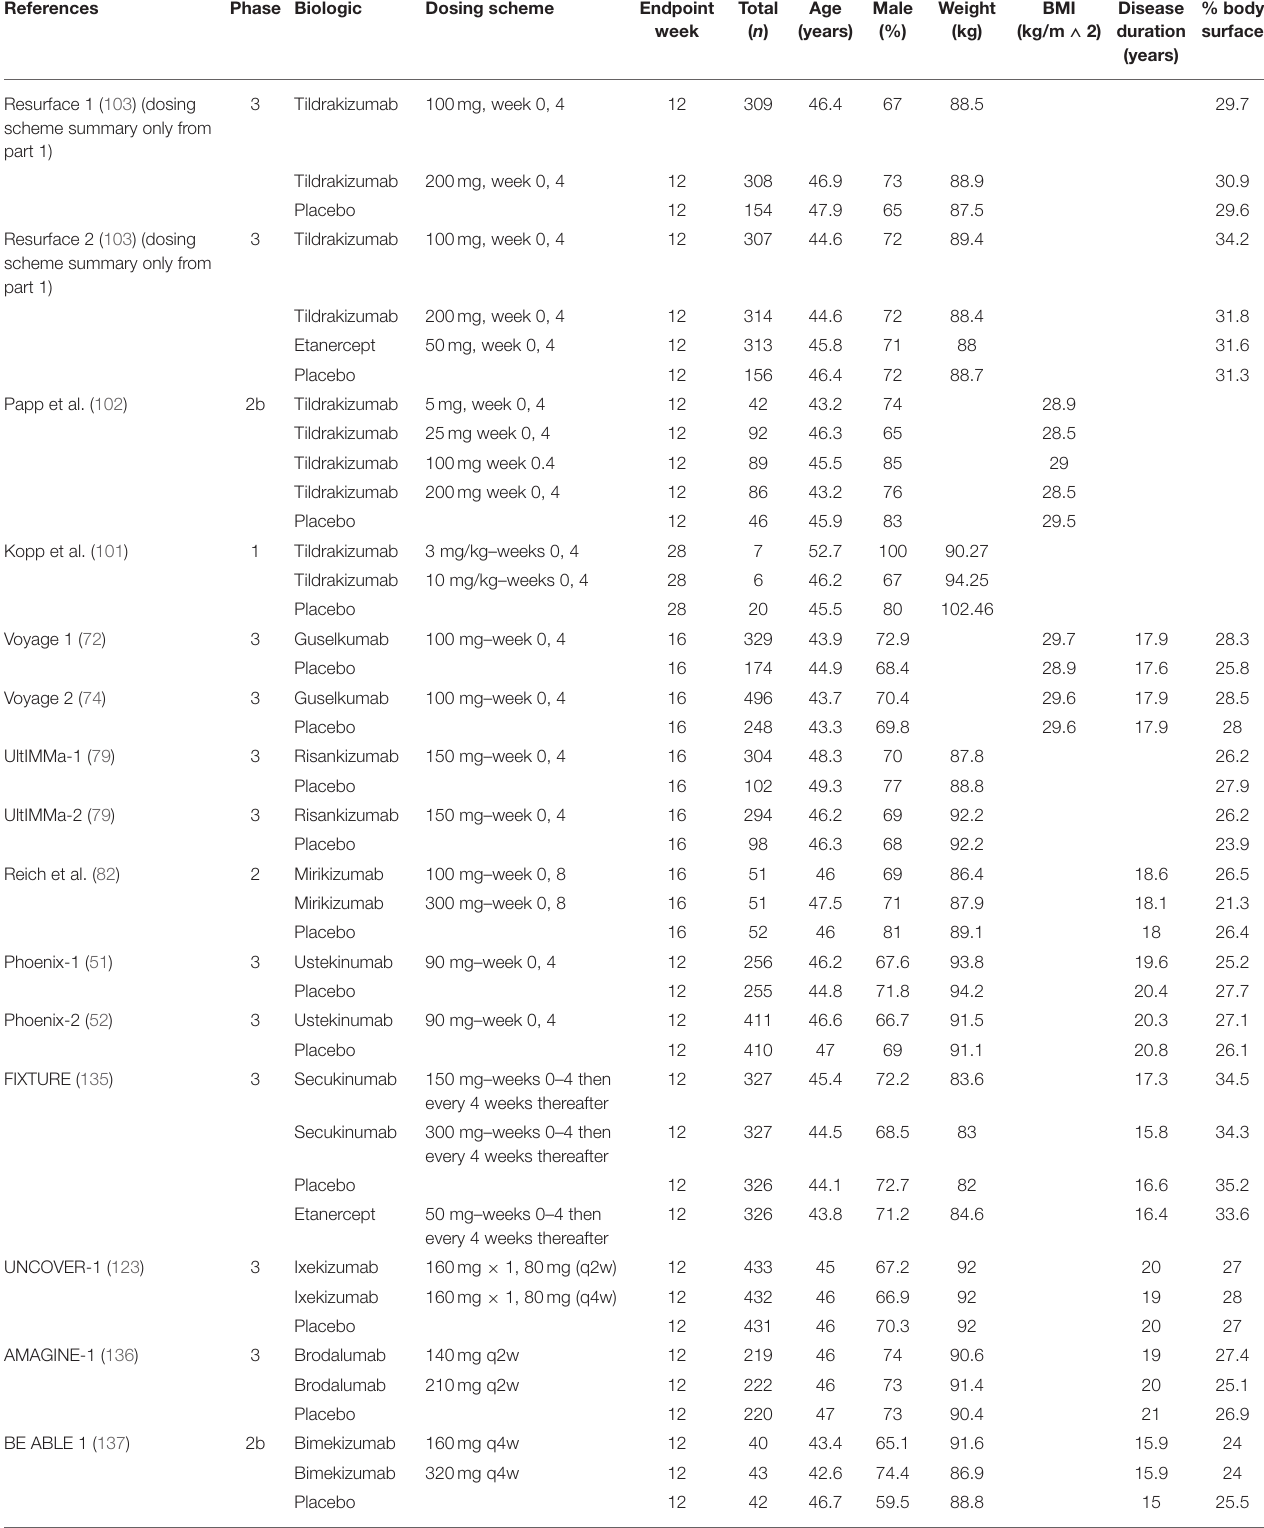
TABLE 2 | Summary of the demographic data of patients enrolled in clinical trials testing the efficacy of IL-23, IL-23/12, IL-17, IL-17RA, and TNF- α